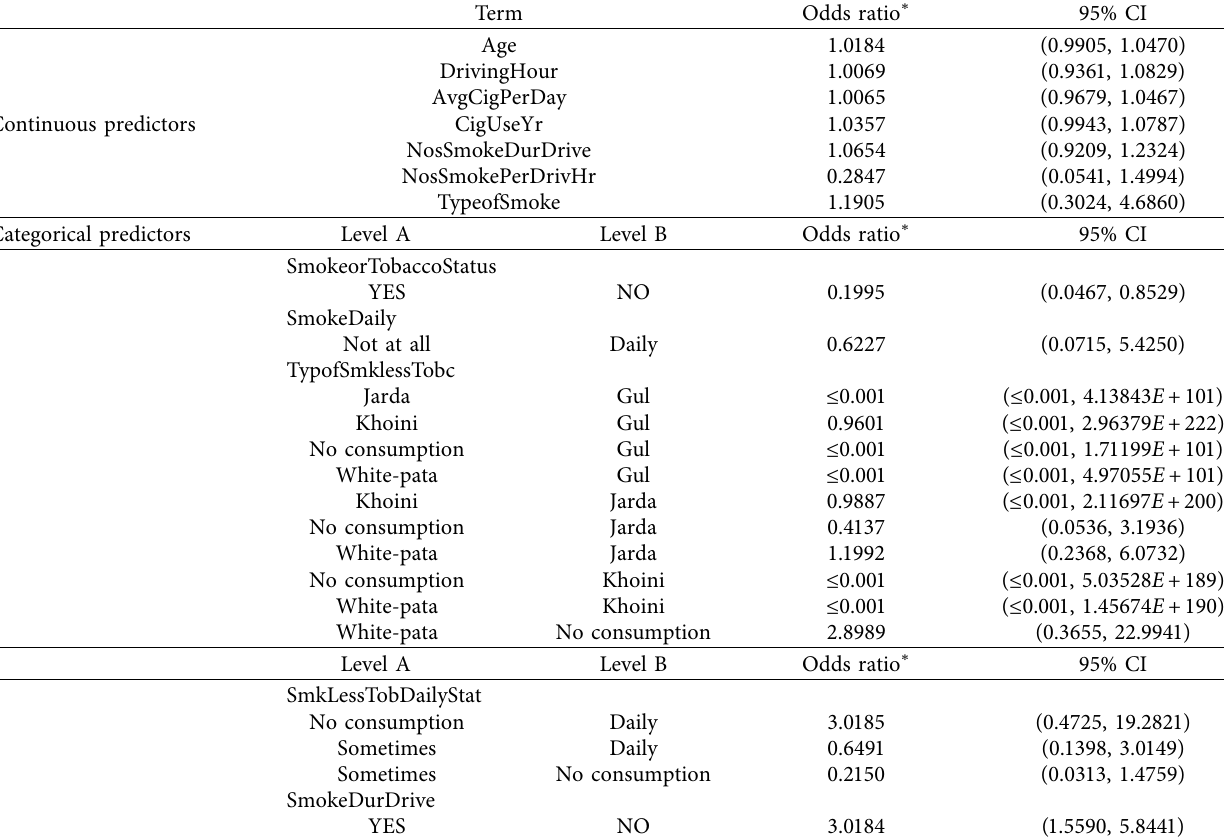
Table 7: Odds ratios for continuous and categorical predictors.